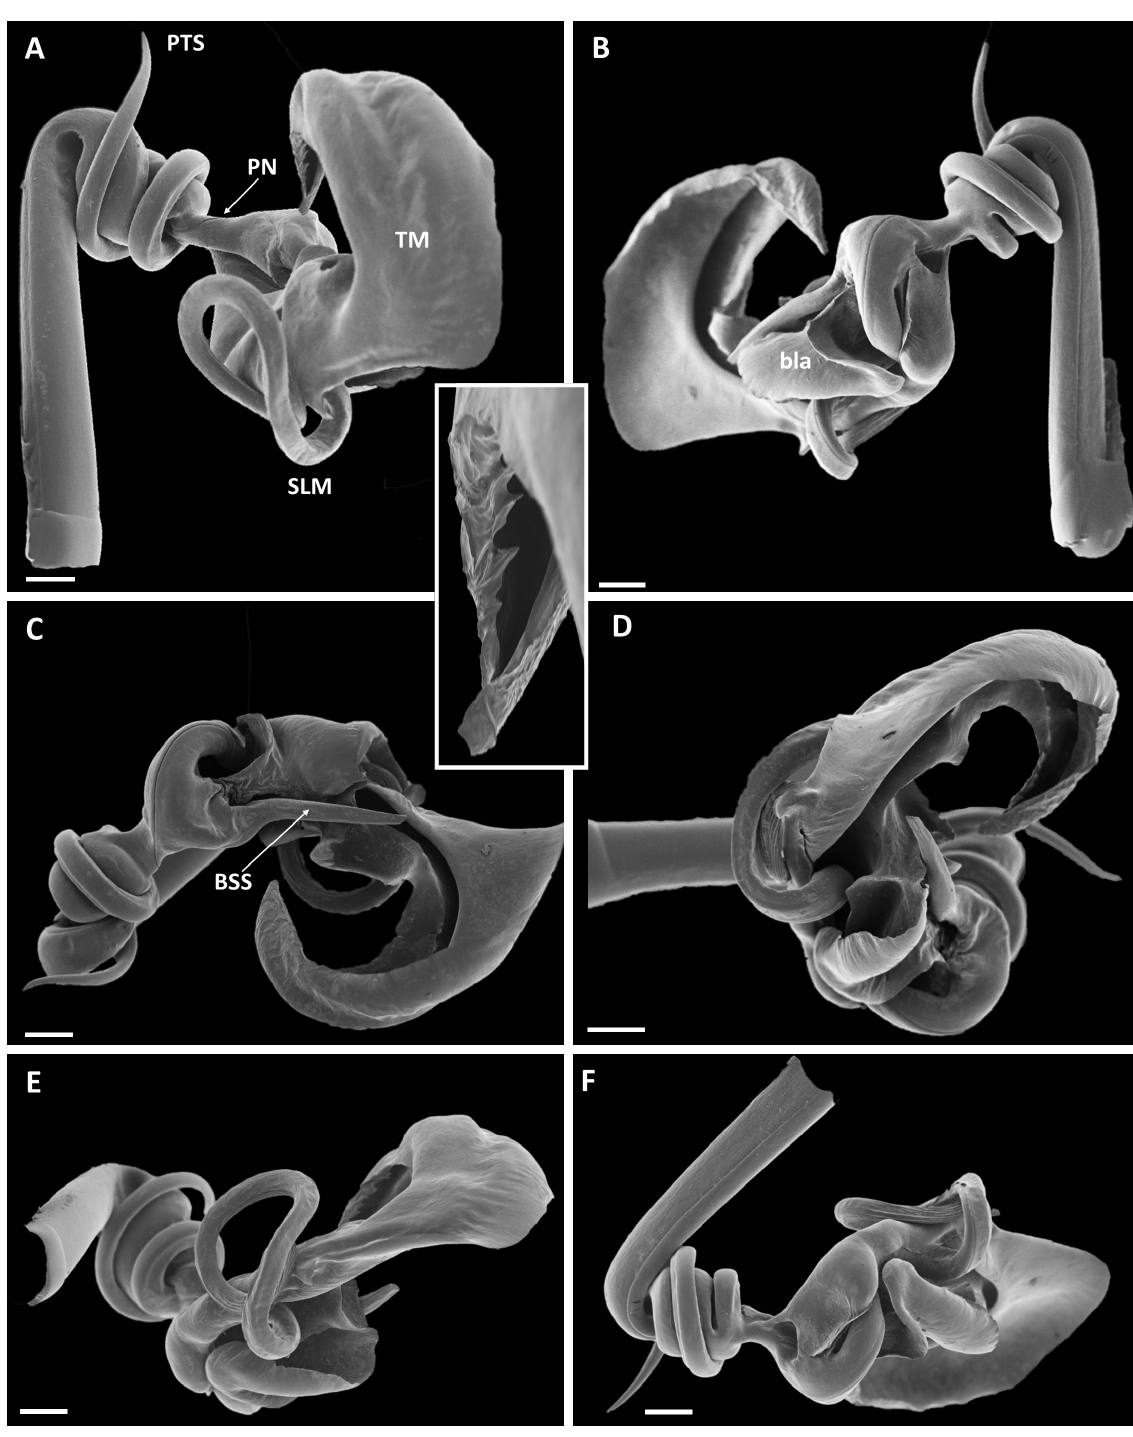
Fig. 55. Spinotarsus axeli sp. nov., holotype, ♂ (NHMD 621761), left gonopod telopodite. A . Anterior view, inset: tip of telomere. B .Posterior view. C . Venral view. D . Dorsal view. E . Anterior-dorso-apical view. F . Posterior-dorsal view. Abbreviations: bla = basal telomeral lamella; BSS = basal solenomeral spine; PN = post-torsal narrowing; PTS = post-torsal spine; SLM = solenomere; TM = telomere. Scale bars = 0.2